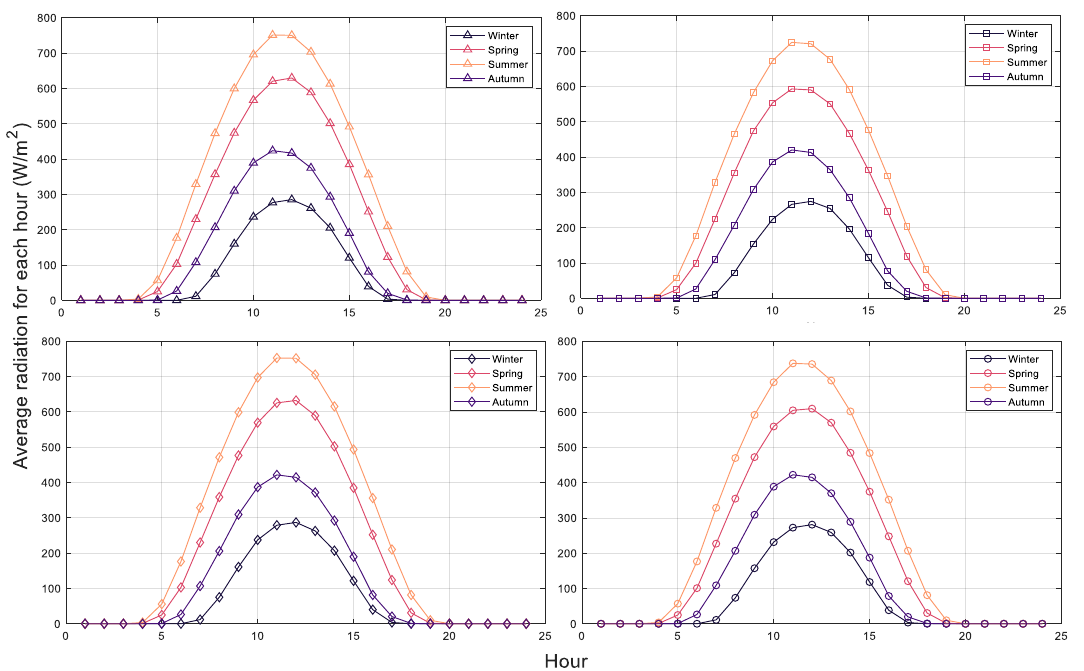
Figure 4. Solar radiation (in W/m 2 ) for each season and daily hour. The square symbol is for Lake Razim; the circle symbol is for Lake Golovita; the triangle symbol is for Lake SInoe; and the diamond symbol is for the Black Sea.